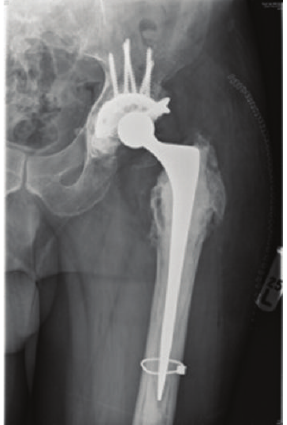
Figure 4: Postoperative radiograph of cemented CPT size 4 extended offset